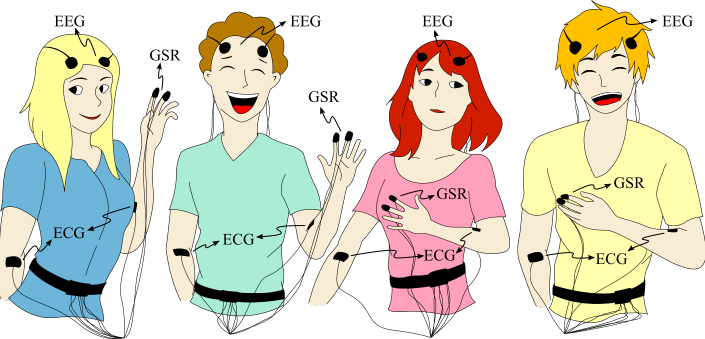
Figure 2. Participants of the AMIGOS database with EEG, ECG, and GSR